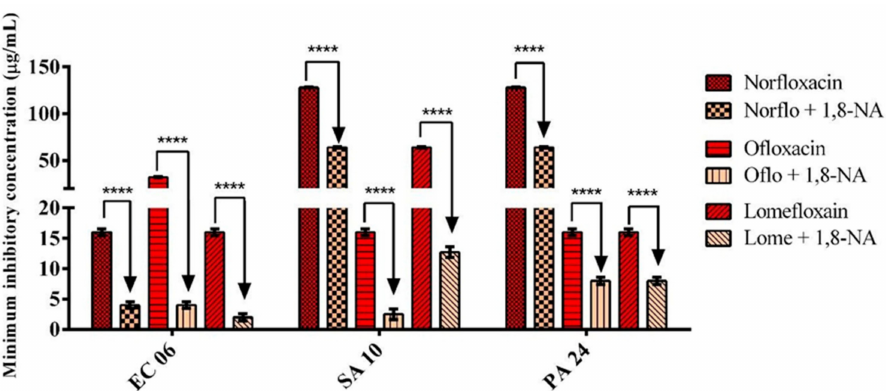
Figure 1. Antibiotic-modulating activity of 7-acetamido-1,8-naphthyridin-4(1 H )-one (1,8-NA) in combination with norfloxacin, ofloxacin, and lomefloxacin against E. coli 06, S. aureus 10, and